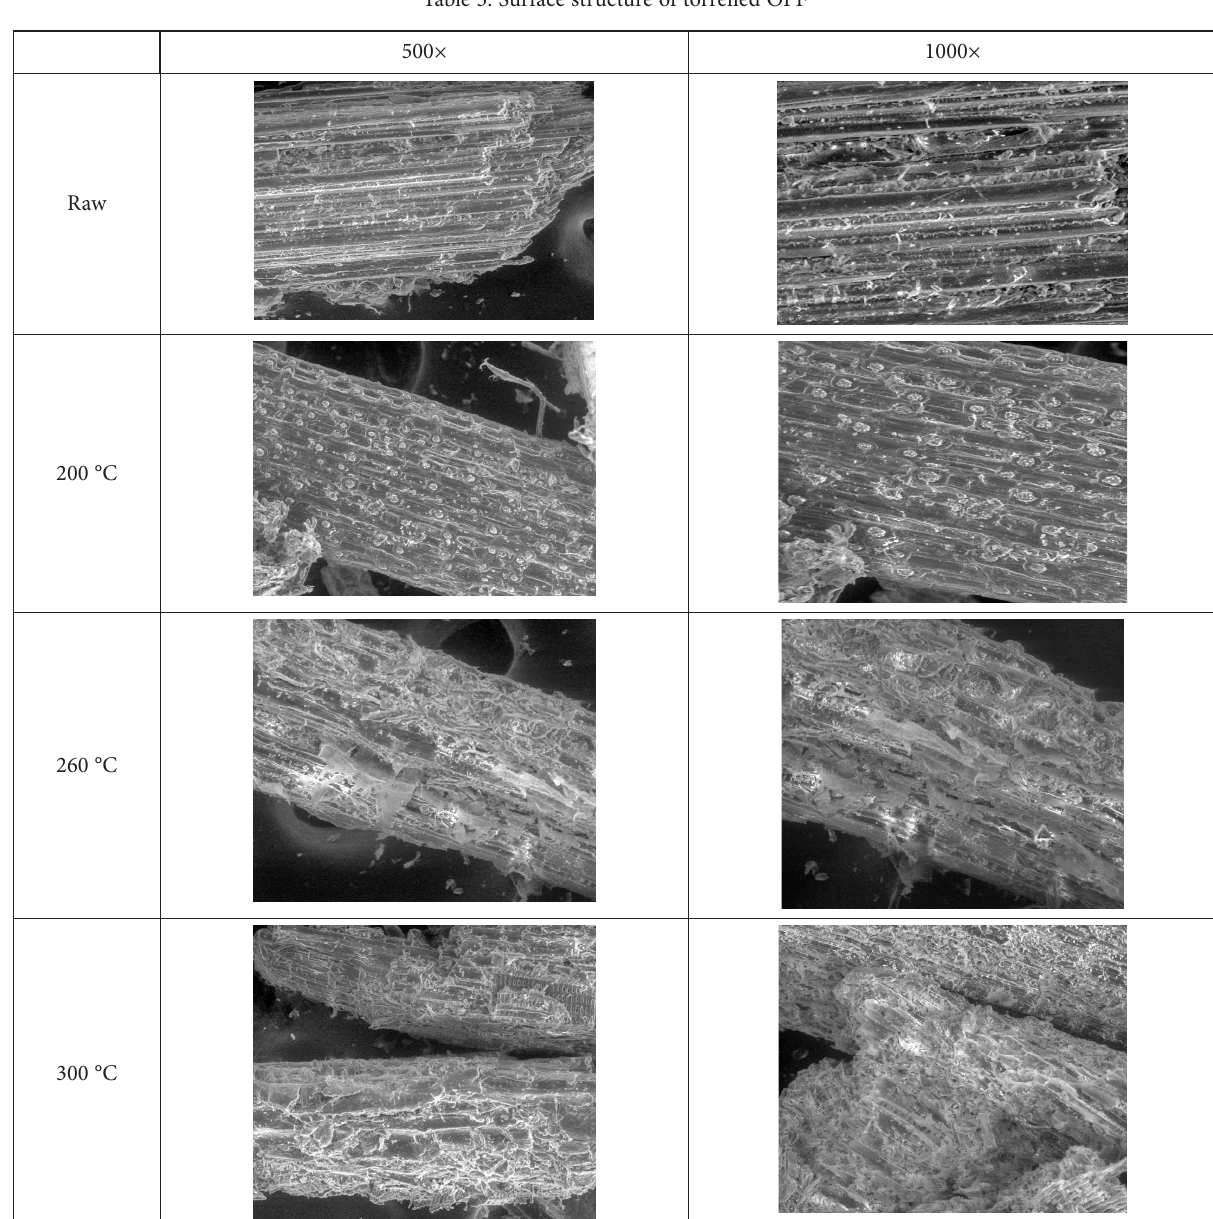
Figure 8. Higher heating value (HHV) for raw and torrefied OPF compared to coal Table 3. Surface structure of torrefied